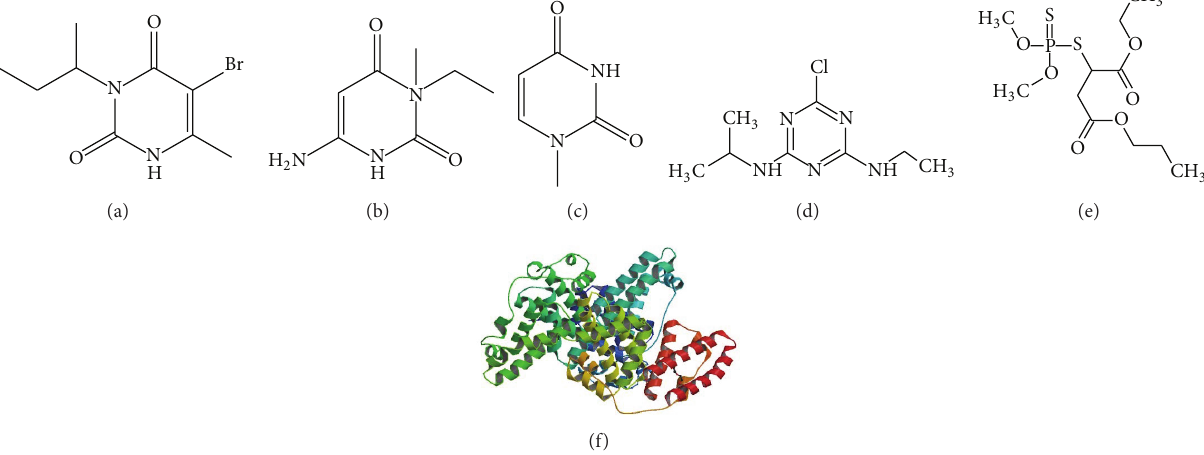
Figure 2: Structures of molecules used in the SELEX scheme and cross binding assays. (a) Structure of the herbicide and target of selection bromacil. (b) Structure of the bromacil metabolite 6-amino-3-ethyl methyl uracil, the 1st negative target. (c) Structure of the bromacil metabolite 1-methyl uracil, the 2nd negative target. (d) Structure of the herbicide atrazine, used in cross-reactivity binding assays. (e) Structure of the pesticide malathion, used in cross-reactivity binding assays. (f) Ribbon structure of bovine serum albumin (BSA) used in cross binding assays